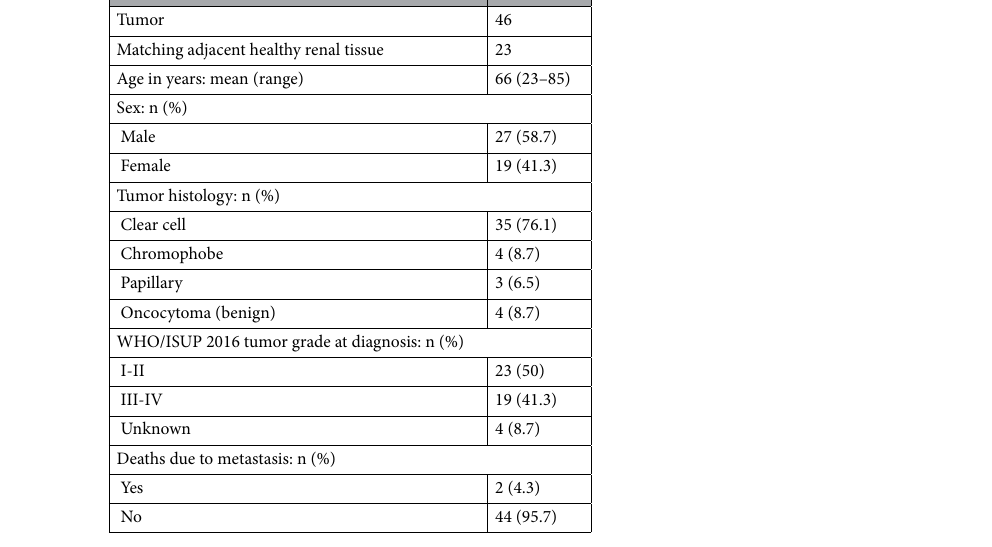
Table 1. Sample cohort and patient